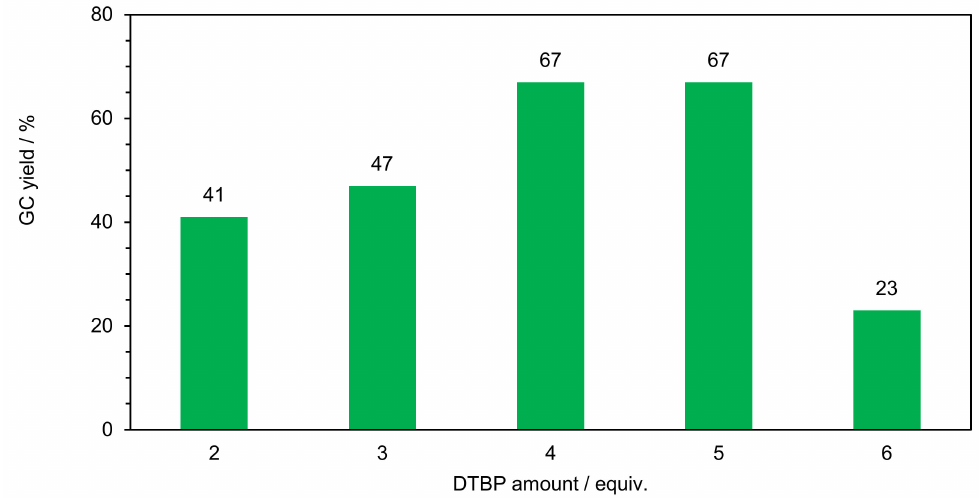
Figure 8. Effect of the amount of the DTBP oxidant on the product yield. Reaction conditions: 1,1-diphenylethylene (0.3 mmol); THF (1 mL); KI (20 mol%); Cu 1 Ce 0.7 Si catalyst (5.6 mg); 120 ◦ C; under air for 20 h.